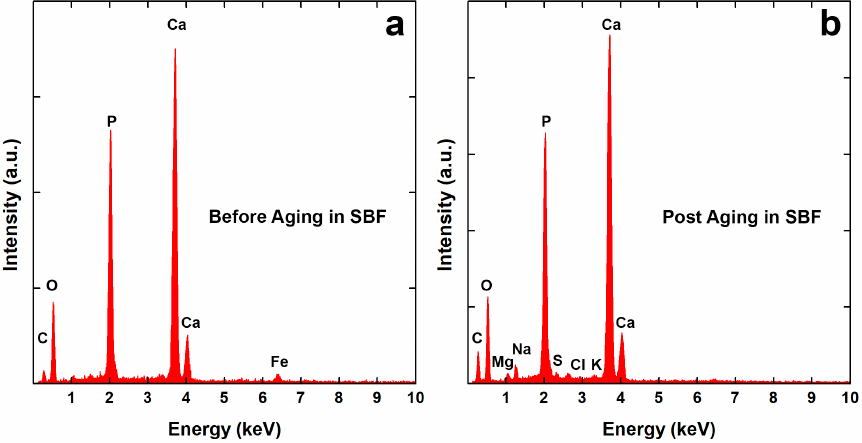
Figure 2. EDS spectra of CaP/CS/CL coating: ( a ) before and ( b ) after aging in SBF.